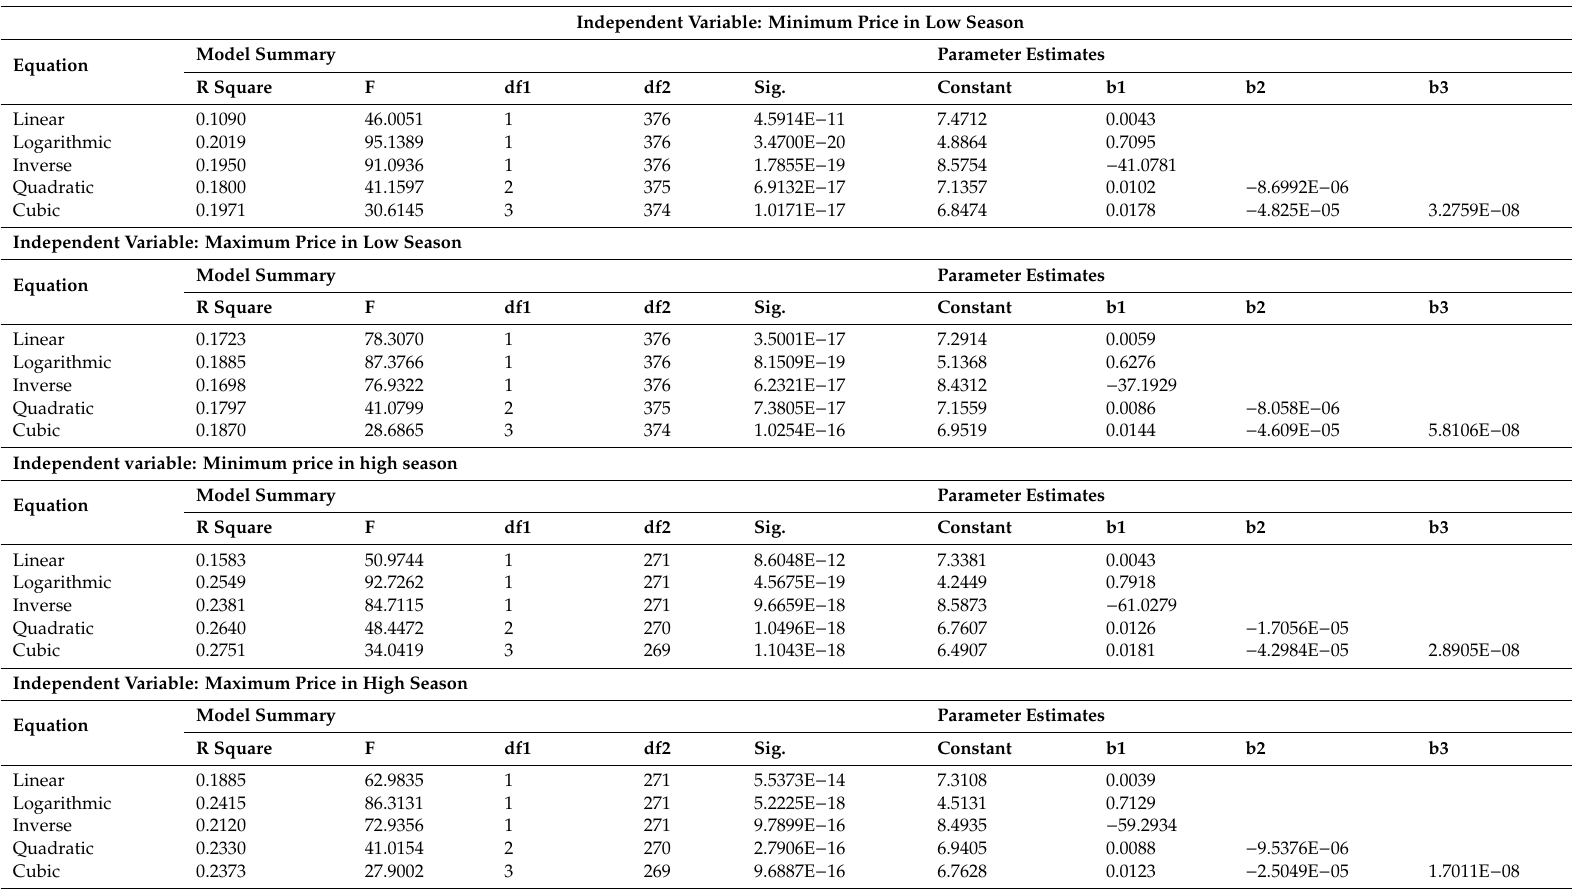
Table 3. Model summary and parameter estimates of regression analysis in all destinations with quality average (Q) as dependent